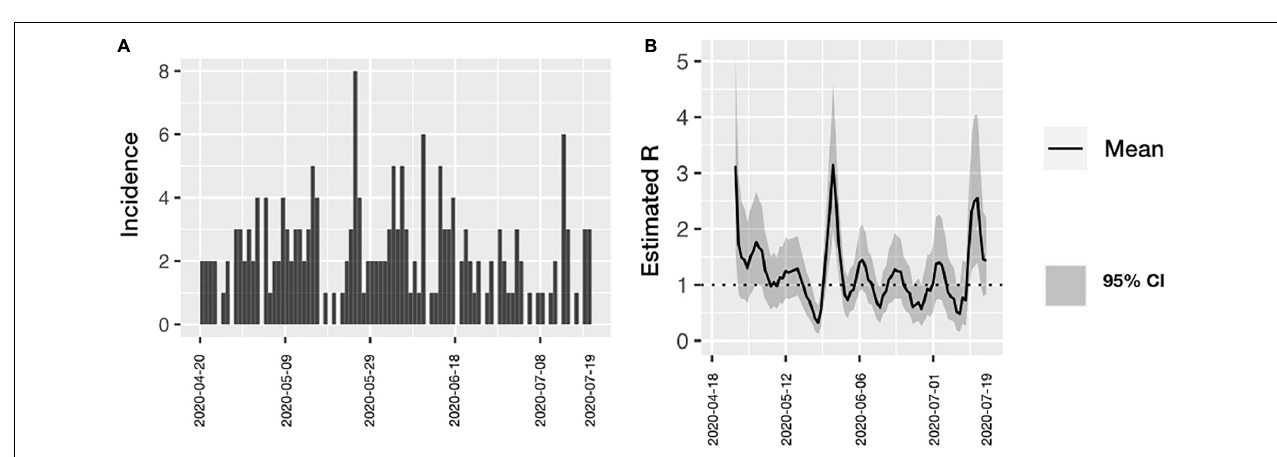
FIGURE 1 | Number of cases according to the identified source (community, health personnel, or patients).